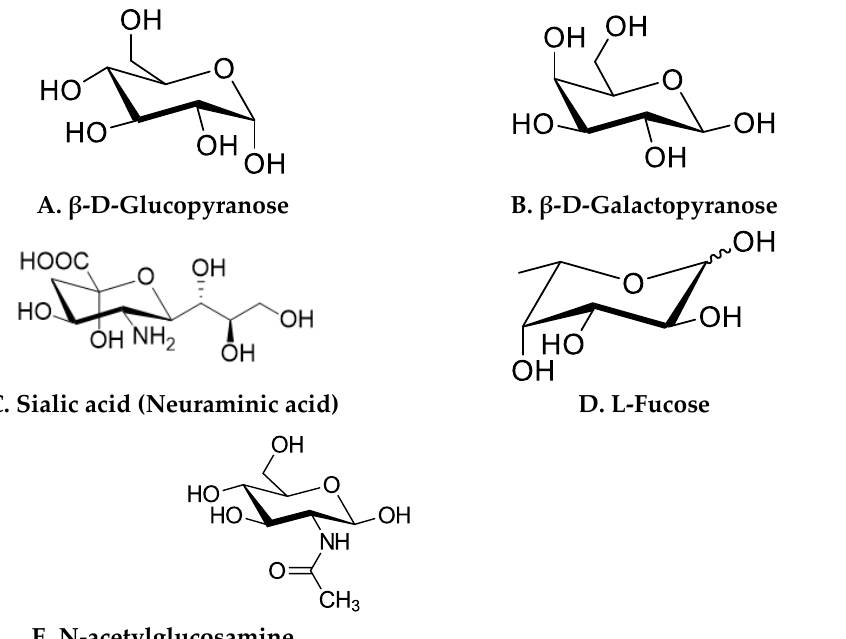
Figure 2. Structures of basic monosaccharide constituents of HMOs. ( A ) β -D-Glucopyranose, ( B ) β -D-Galactopyranose, ( C ) Sialic acid (Neuraminic acid), ( D ) L-Fucose, ( E ) N-acetylglucosamine. A lactose molecule forms the backbone of all HMOs [32,34]. The lactose residue is further modified by the addition of N - acetylglucosamine by β 1 – 3 or β 1 – 6 bonds. β 1 – 3